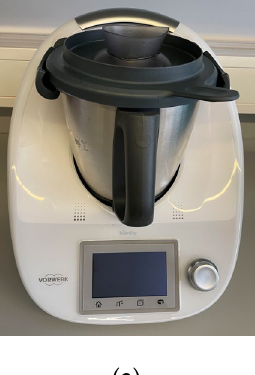
Figure 3. Equipment used for processing the olive pomace paste: ( a ) Thermomix TM 31; ( b ) SANYO Labo autoclave; ( c ) Telstar Cryodos - 80 Terrassa .